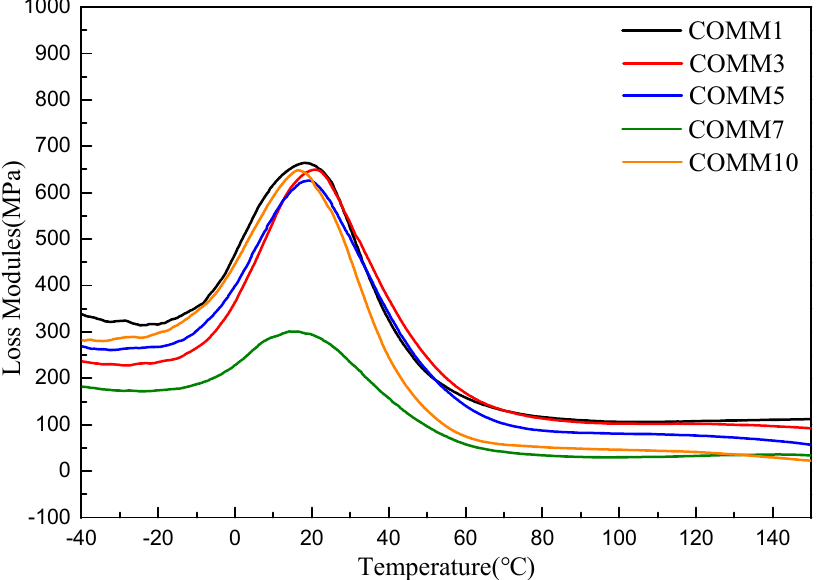
Figure 10. DMA of PA6 containing dimer oleic acid and 4,4'-Methylenebis(2-methylcyclohexylamine).